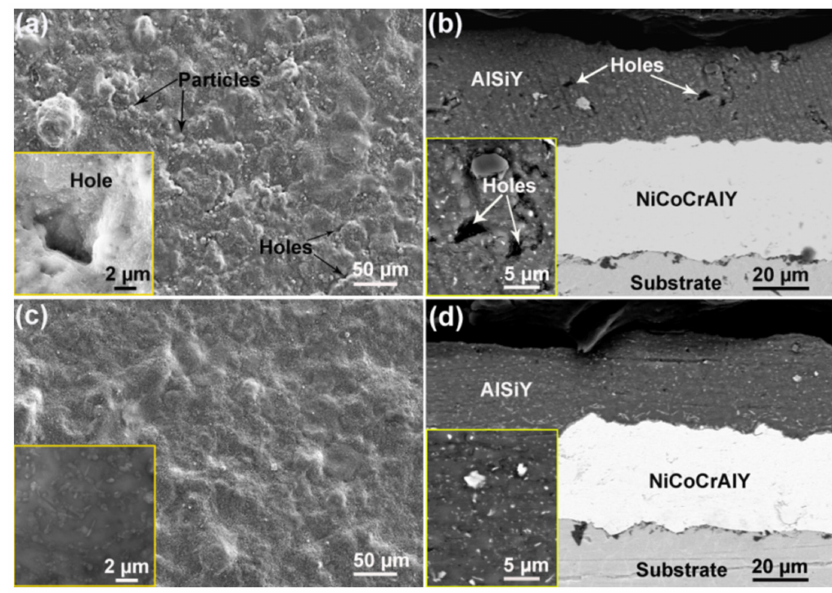
Figure 2. Surface and cross-sectional images of samples E1 ( a , b ) and E2 ( c , d